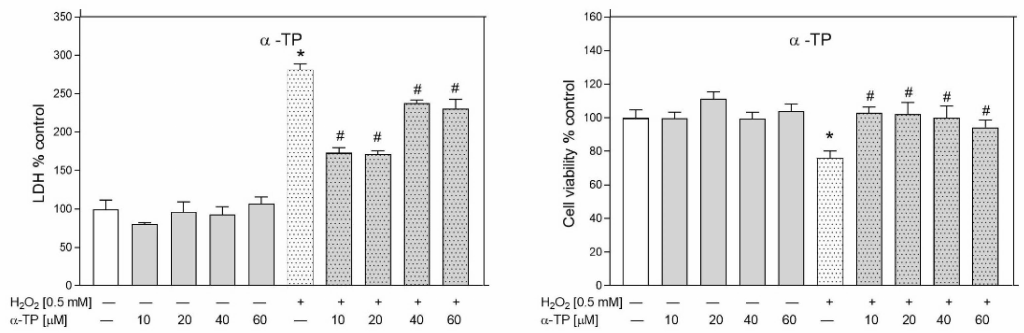
Figure 11. Effect of α -TP against H 2 O 2 -induced RA-SH-SY5Y cells damage. The cells were incubated with α -TP (10–60 µ M) and H 2 O 2 (0.5 mM) for 24 h, followed by measurement of cell toxicity by LDH release assay ( left panel ) and cell viability by MTT reduction assay ( right panel ). Data after normaliza- tion to control cells (100%) are presented as the mean SEM from 2–4 independent experiments with ± five replicates. All group means were compared by a two-way ANOVA test followed by Duncan’s post hoc test. * p < 0.05 versus control culture and # p < 0.05 versus H 2 O 2 -treated